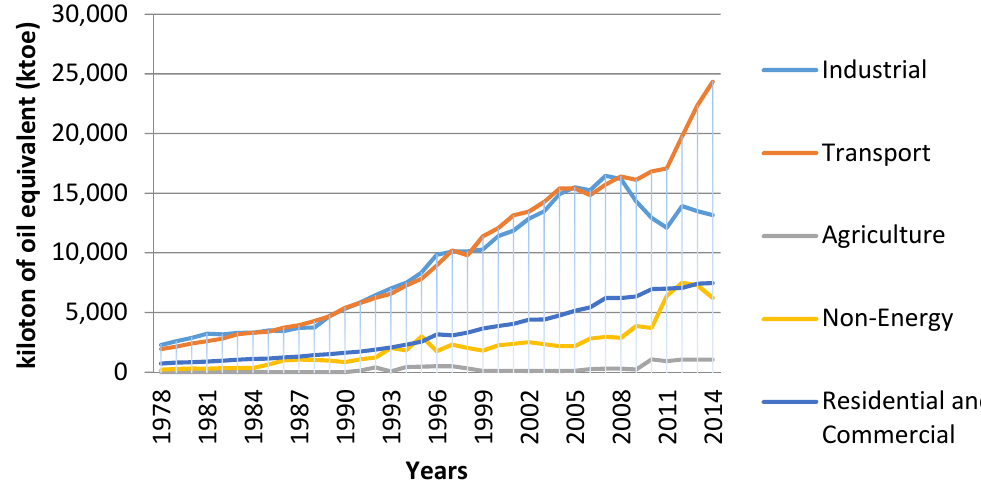
Figure 2. Energy demand in Malaysia by sector (source: Malaysia Energy Information Hub [3]).